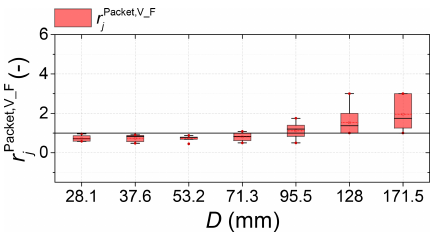
of the total number of real packets Figure 7. The ratio r Packet , V_F i,j for all transport modes based on the video analysis to the number of real packets determined by the filtering method for each particle size class j